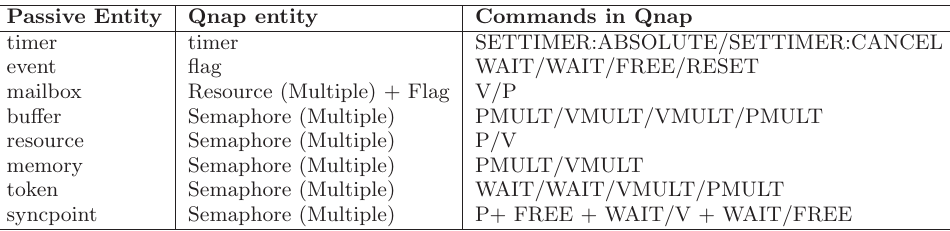
Table 2: Passive entities implementation in Qnap